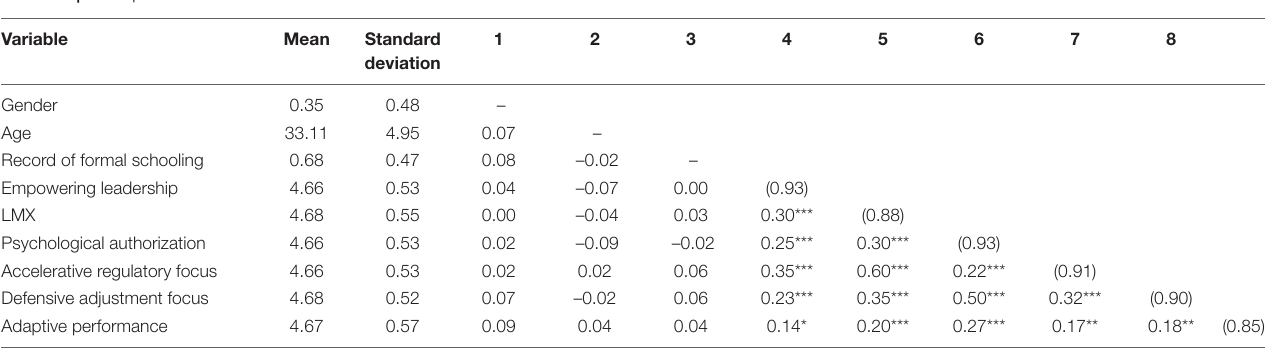
TABLE 2 | Descriptive statistical results and correlation coefficient matrix.